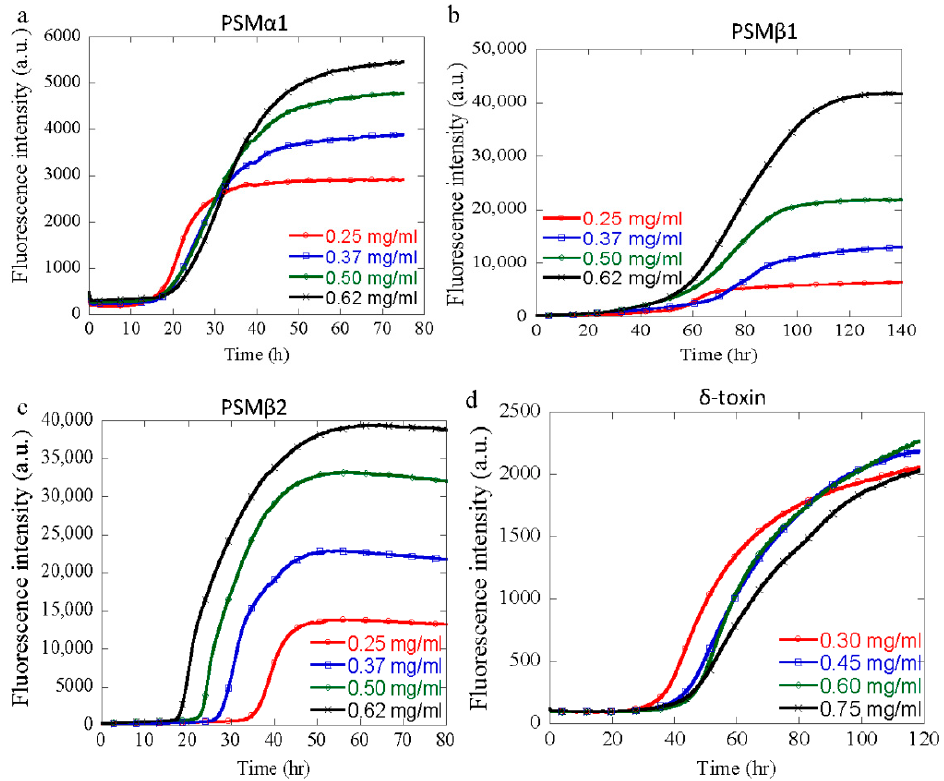
Figure 3. Aggregation kinetics of different PSMs as a function of peptide concentration at fixed pH. Each peptide concentration was run in triplicates. ( a ) Aggregation kinetics of PSM α 1 at pH 2 show fibrillation with lag-phase followed by ThT fluorescence at various concentrations (0.25–0.62 mg/mL). ( b ) Aggregation kinetics of PSM β 1 at pH 10 show fibrillation with lag-phase followed by ThT fluorescence at various concentrations (0.25–0.62 mg/mL). ( c ) Aggregation kinetics of PSM β 2 at pH 10 show fibrillation with lag-phase followed by ThT fluorescence at various concentrations (0.25–0.62 mg/mL). ( d ) Aggregation kinetics of δ -toxin at pH 2 show fibrillation with lag-phase followed by ThT fluorescence at various concentrations (0.3–0.75